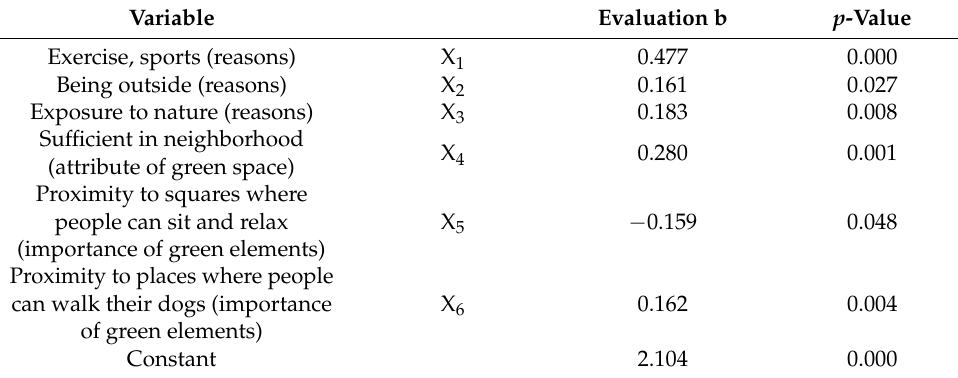
Table 5. Parameter values of the multiple regression model describing the relationship between the Green Physical Activity Indicator and greenery preference and the corresponding p -values.